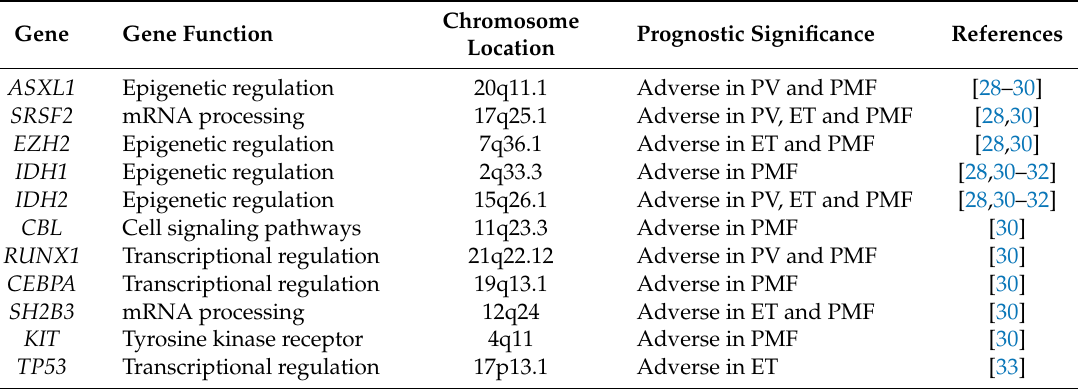
Table 1. Biological Risk